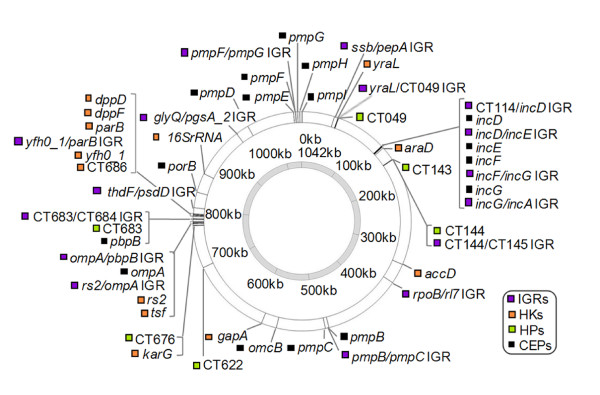
Loci distribution in the approximately 1.04 Mb C. trachomatis circular chromosome. Gene names and open reading frame numbers are based on the C. trachomatis D/UW3 genome annotation [GenBank: AE001273]. Loci categories are illustrated by different colors. Only the first nucleotide of each locus is marked on the figure.